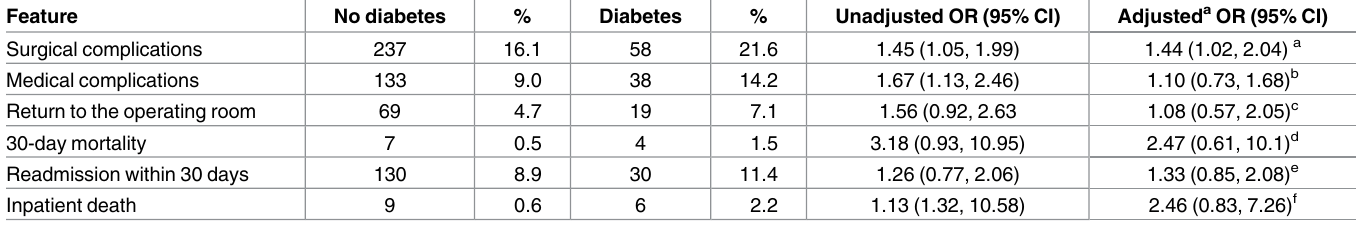
Table 5. Outcomes of study